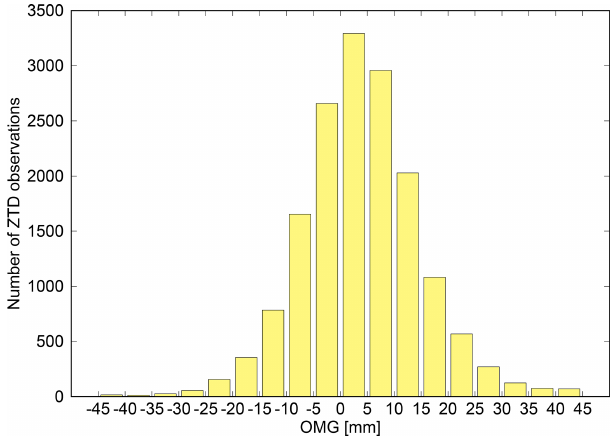
Figure 5. Distribution of OMF values for all GNSS stations inside AROME/Hungary’s domain. The period of 15–31 May 2017 was used for the calculation of OMF